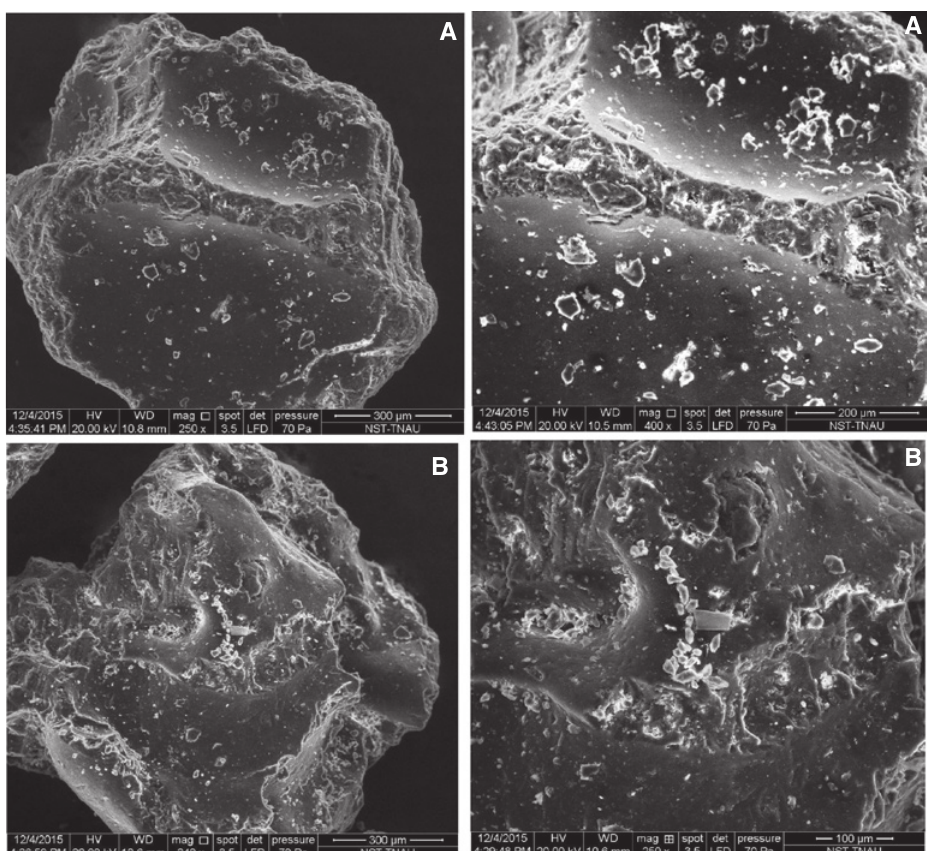
Figure 3: SEM image of CNS filler: (A) raw filler and (B) NaOH treated